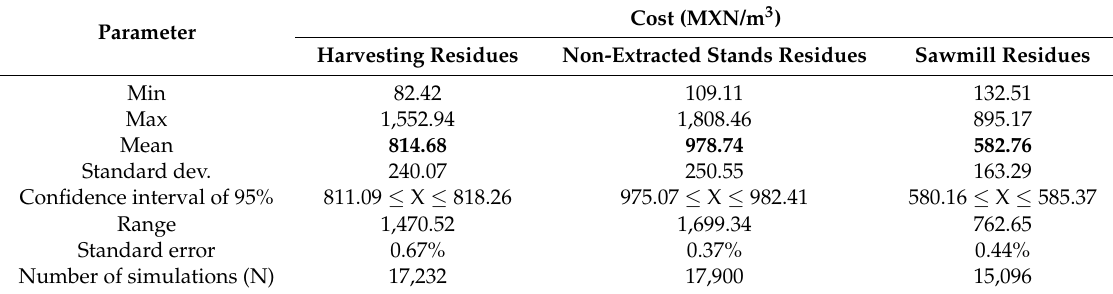
Table 7. Monte Carlo simulation results according to cost for the central south